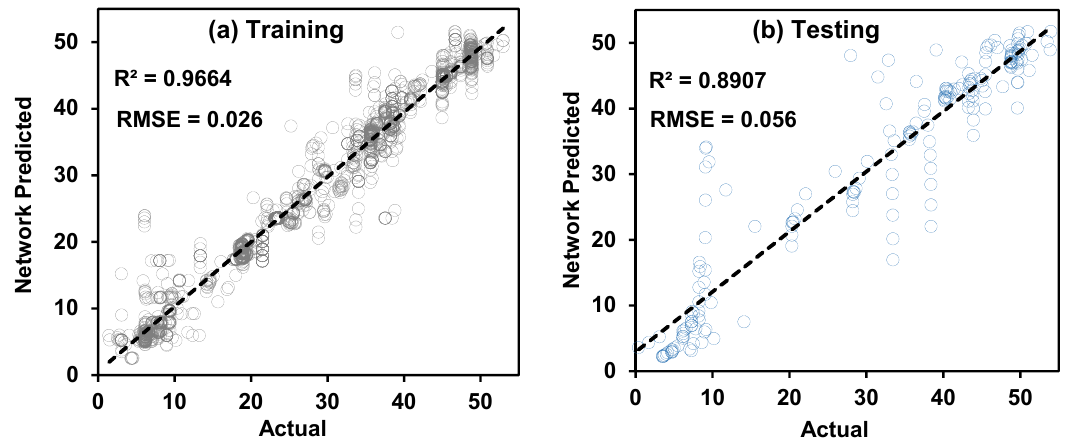
Figure 6. Network calculated battery data using Tanh as the activation function during ( a ) training and ( b ) testing of the NN 1 model.